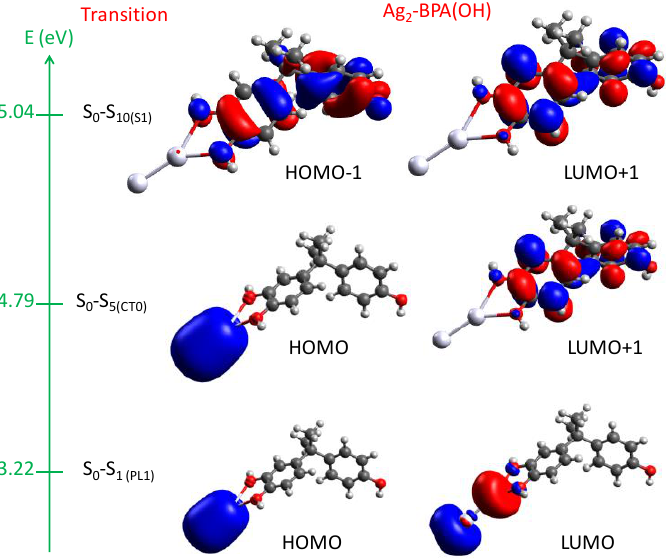
Figure 3. Molecular orbitals of the three types of electronic transition in the Ag 2 -BPA(OH) complex coordinated through the oxygen atoms.